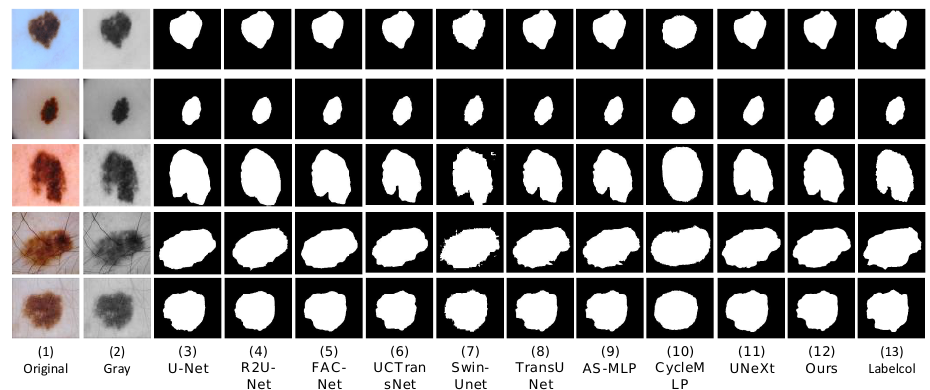
Figure 11. At ISBI2016, a visual segmentation comparison map was created for each compared network. ( 1 , 2 ) The input original image and grayscale image, and ( 13 ) the label-col map. ( 3 – 11 ) The segmentation results of the comparison networks, respectively. ( 12 ) The segmentation result of our proposed method from which we can see that the segmentation result of our proposed algorithm is closest to the label-column map.